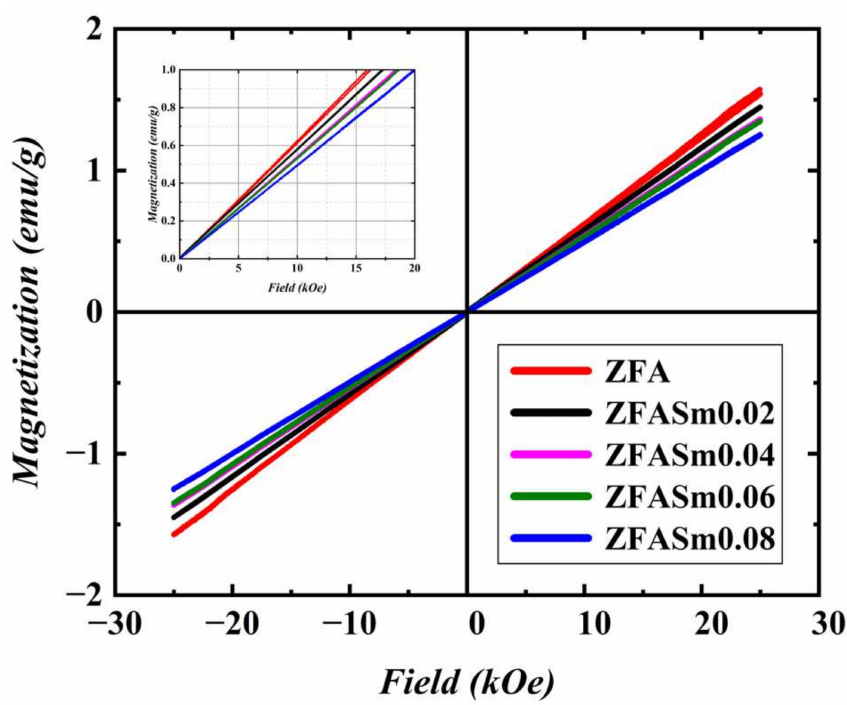
Figure 4. Hysteresis loops recorded at room temperature for ZnAlFe 1 − x Sm x O 4 (x = 0, 0.02, 0.04, 0.06, 0.08) photocatalysts.